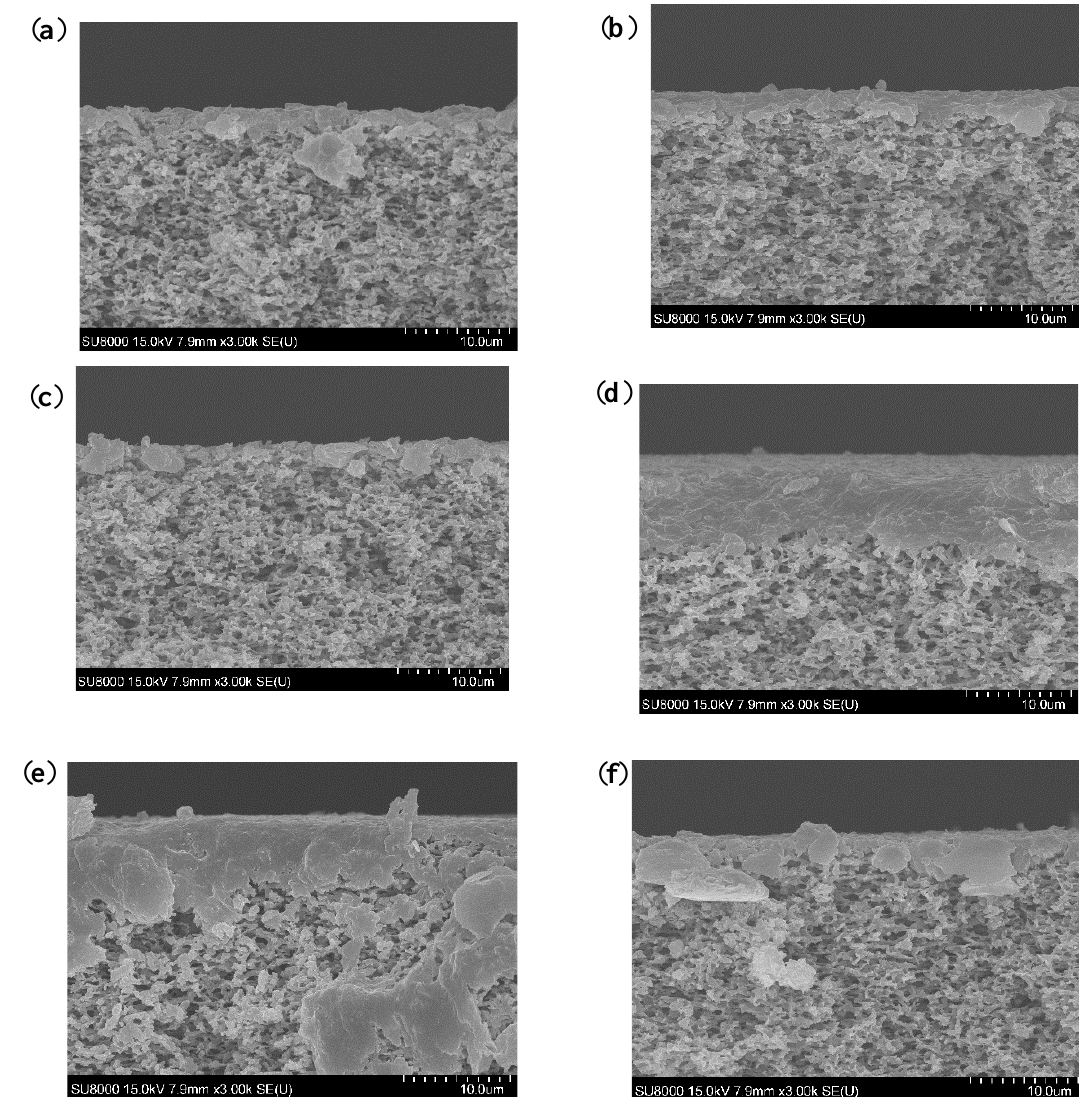
Figure 2. Cross-section view of the fouled membranes at different pH and temperatures ( a ) 35 °C, pH 4, ( b ) 35 °C, pH 6, ( c ) 35 °C, pH 8, ( d ) 50 °C, pH 4, ( e ) 50 °C, pH 6, and ( f ) 50 °C, pH 8.